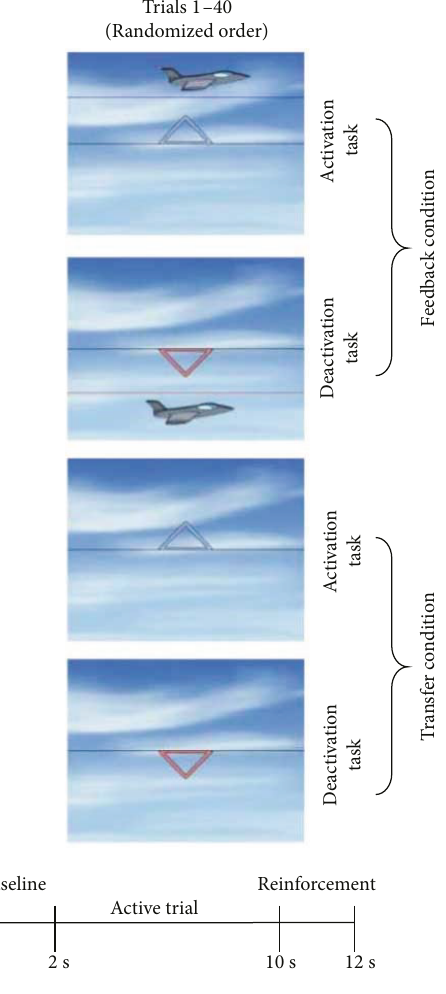
Figure 2: Setup of the SCP-NF. Feedback/transfer condition: condition where a feedback stimulus is (feedback) or is not (transfer) visible. Deactivation task: generation of positive potential shifts. Activation task: generation of negative potential shifts. 1 double session consists of 4 blocks with 40 trials each, each block including feedback and transfer conditions and deactivation/activation tasks as illustrated (pictures by Ilmenau, neuroConn GmbH).